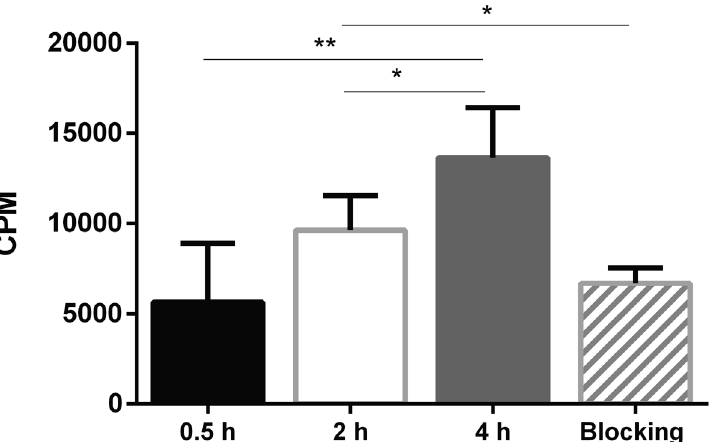
Figure 2. Binding assay with Sgc8-c-NOTA- 67 Ga in the B16F10 cell line. The probe was incubated for 0.5, 2 and 4 h. Blocking: represents the competition test performed by incubating the cells with an excess of unlabeled aptamer (Sgc8-c-NH